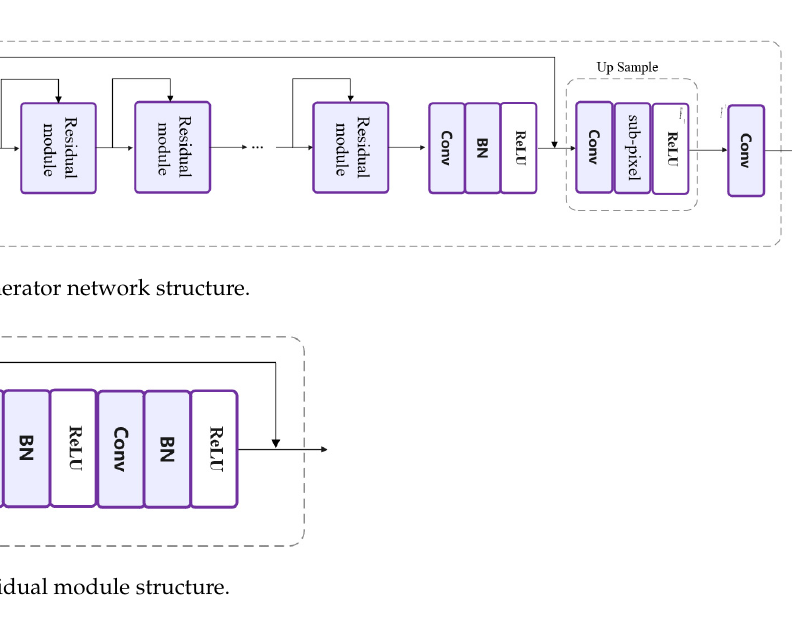
Figure 4. Discriminator structure. In order to improve the final image generation effect in the SRGAN network, the composition of the loss function is changed, and the concept of perceptual loss [15] is in- troduced. In the original SRGAN, loss is defined as the sum of different weights of content loss and adversarial loss, as shown in Equation (1), where